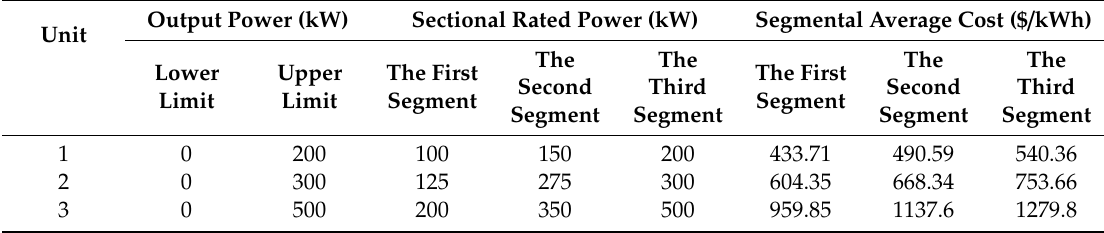
Table 1. The operation cost parameter of diesel generator